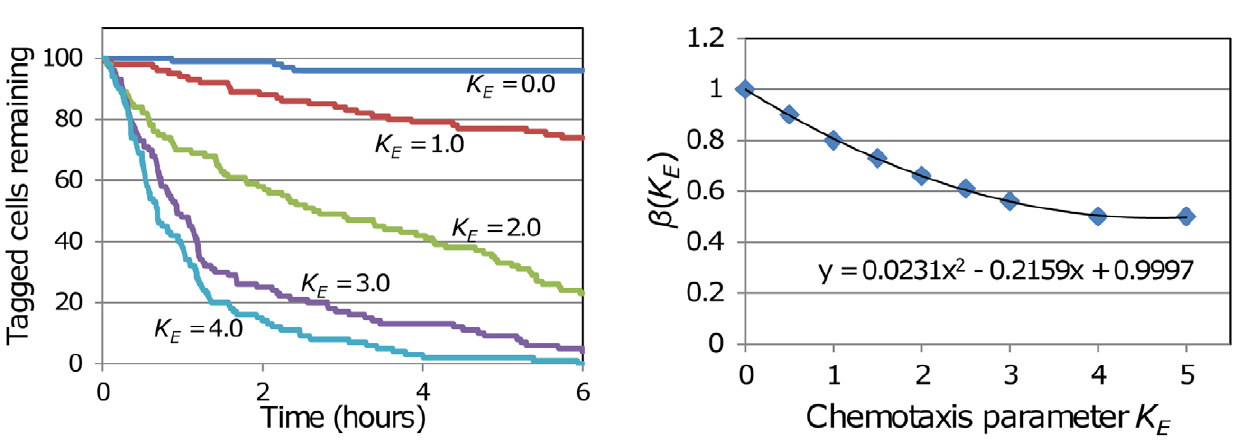
Figure 6. Adjustments to N E to maintain steady-state with varying K E . The formula for the base number of exit portals N E was determined with no chemotaxis ( K E =0). When there is exit chemotaxis ( K E . 0) the number of exits must be reduced to ensure that the steady- state T cell population is maintained. Numerical experiments were used to determine the needed reduction factor b (K E ) for K E ranging up to